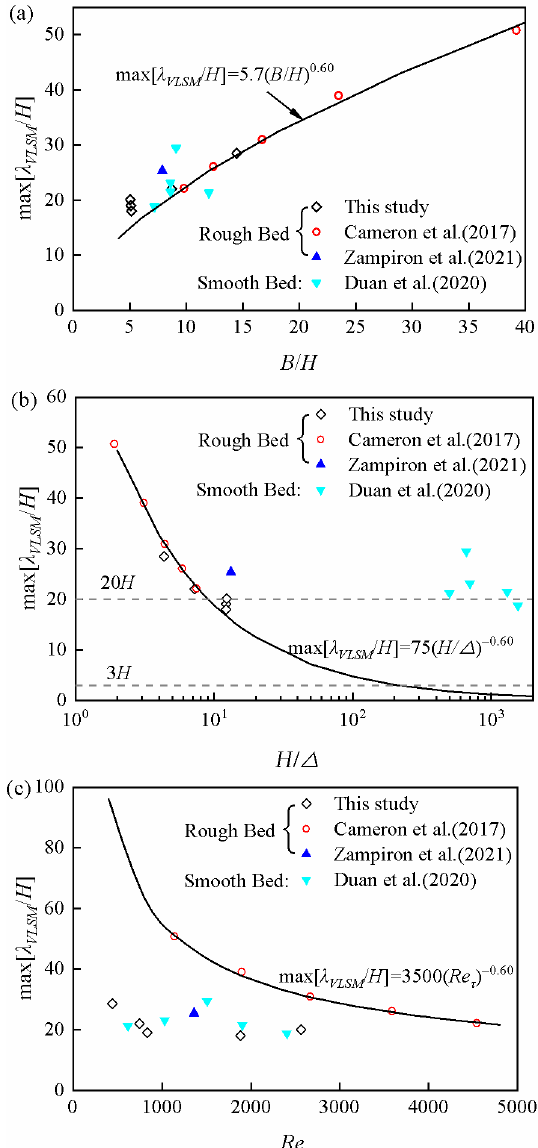
Figure 5. Maximal VLSM wavelengths versus ( a ) flow aspect ratio, ( b ) relative submergence, and ( c ) friction Reynolds number. The solid line shows the scaling relationship for the VLSM wavelengths proposed by Cameron et al. [11]. The experimental data for rough beds were from Cameron et al. [11] and Zampiron et al. [38] and the data for a smooth bed was from Duan et al. [8]. The variations in γ uu and γ uv with the flow depth are plotted in Figure 6. The